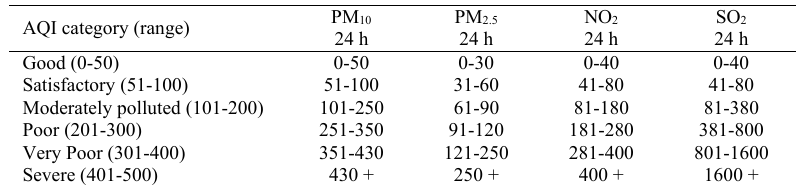
Table 3: Breakpoint of AQI Scale (0 -500) (μg/m 3 )